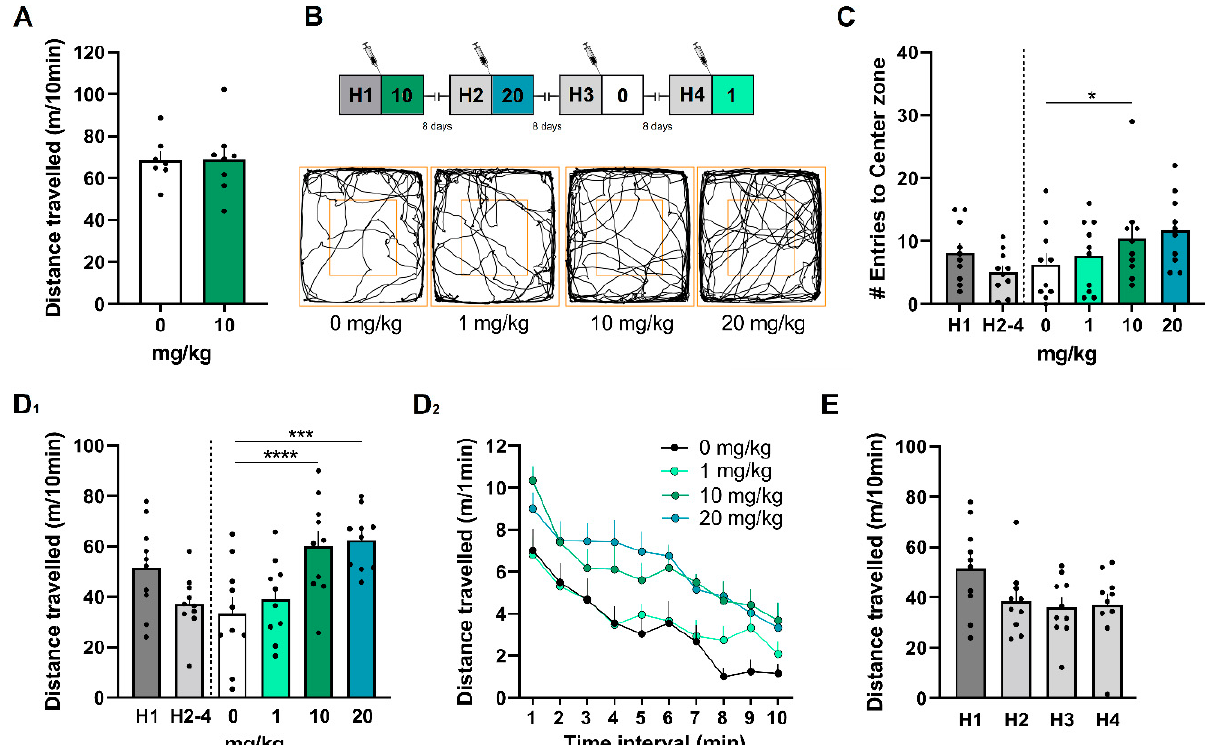
Figure 2. Effect of S-CE-123 on locomotor activity in an open field apparatus. ( A ) A novelty test did not show significant effects on distance travelled at 10 mg/kg ( p > 0.05, unpaired t -test, n = 7–8). ( B – E ) Familiar OF. ( B ) Schematic demonstration of experimental design and representative traces of locomotor activity recorded during test sessions with 0, 1, 10 and 20 mg/kg S-CE-123. ( C ) Number of entries to the center zone. ( D 1 ) Total distance travelled over 10 min and ( D 2 ) 1 min intervals. ( E ) Baseline activity measured during habituation sessions (all rats received vehicle at 1 mL/kg; H1–novelty session, H2-4–familiar sessions). One-way RM-ANOVA followed by Dunnett post hoc test for multiple comparisons; * p < 0.05, *** p < 0.001, **** p < 0.0001. Values are presented as mean ± SEM, n =